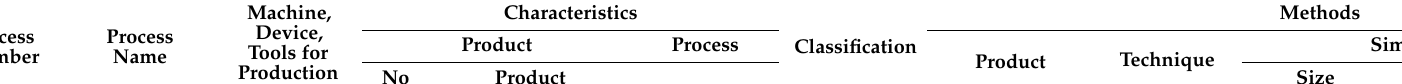
Table 3. Image illustrating the flowmeter product inspection